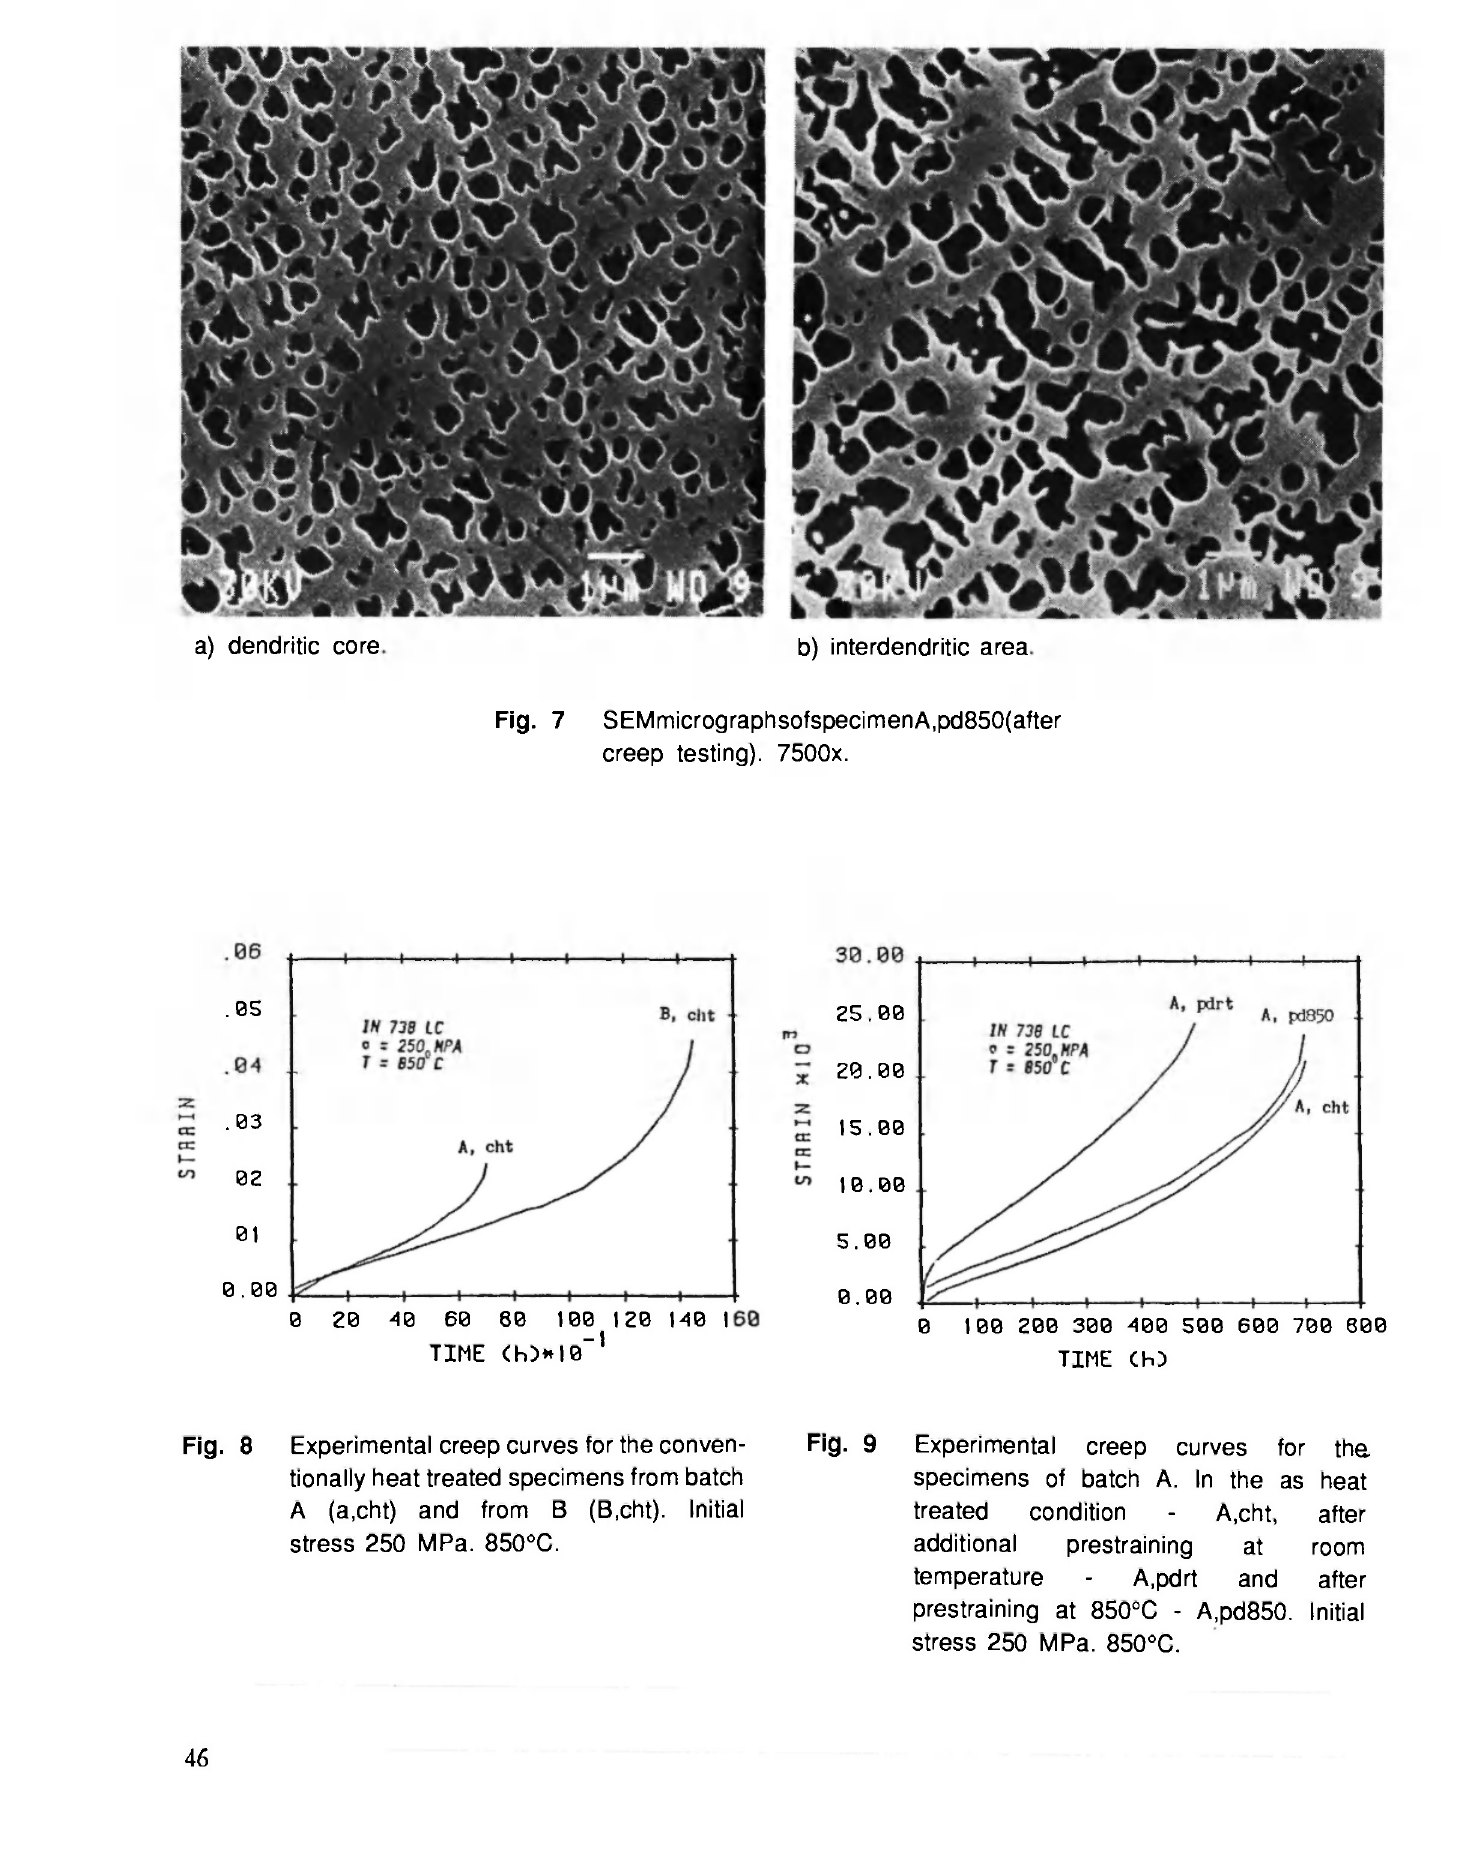
Fig. 8 Experimental creep curves for the conven- tionally heat treated specimens from batch A (a,cht) and from Β (Β,cht). Initial stress 250 MPa. 850°C.